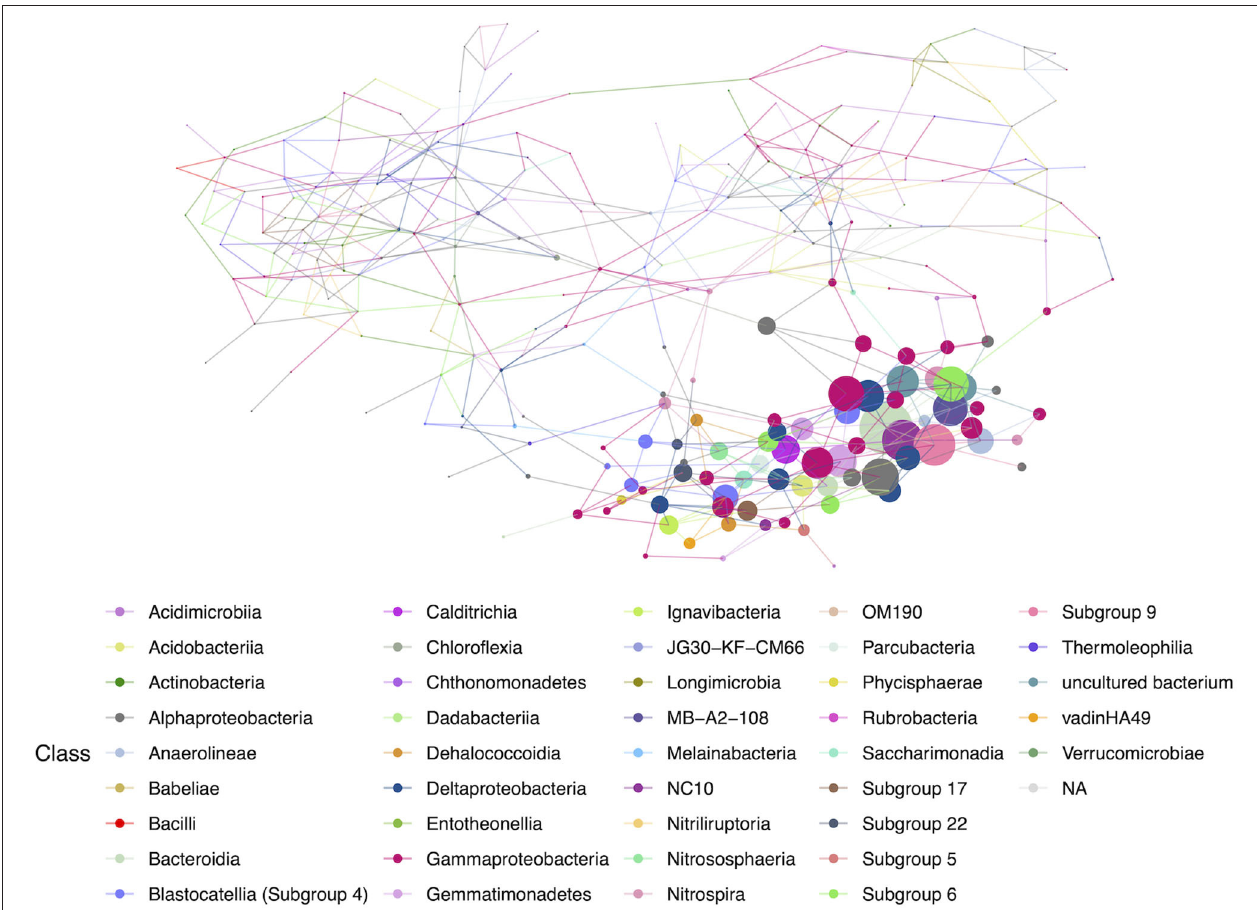
FIGURE 8 | Hub network for lava tubes, suggesting lower complexity than the geothermal network. There are 69 ASVs with an above-average hub score, represented by larger circles on the network graph. Hubs are taxa that most likely have important ecological roles, such as keystone species, and help maintain the overall network structure.